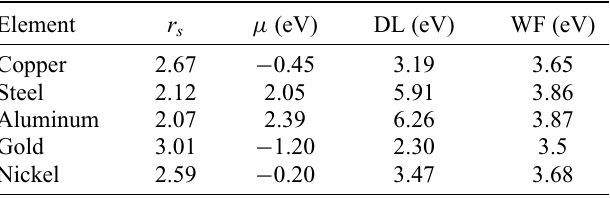
TABLE II. The electron work functions (WF) for several rele- vant metals surrounding the experiments that we consider. If not available in Ref. [80], interpolation is used to estimate the num- bers using the known r s values. The double-layer contribution (DL) and the remainder of the work function ( μ ) are also shown. Element r s μ (eV) DL (eV) WF (eV) Copper 2.67 − 0.45 3.19 3.65 Steel 2.12 2.05 5.91 3.86 Aluminum 2.07 2.39 6.26 3.87 Gold 3.01 − 1.20 2.30 Nickel 2.59 − 0.20 3.47